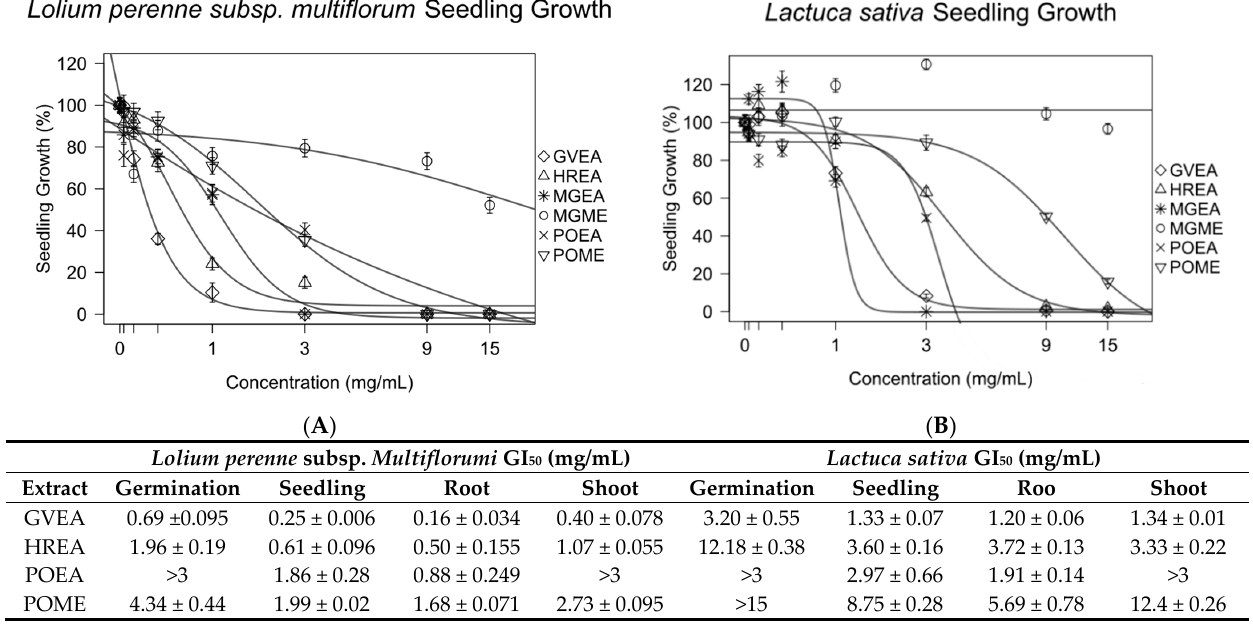
Figure 3. Extracts from plants known to have antileukemic compounds showed strong inhibitory effects on the seedlings of Lolium perenne ( A ) and Lactuca sativa ( B ). Experiments were conducted in triplicate. The concentrations that produced 50% growth inhibition (GI 50 ) of germination and the growth of seedlings, roots, and shoots were calculated from a nonlinear regression of concentration– response models. All data are presented as the mean ±SEM ( C ).